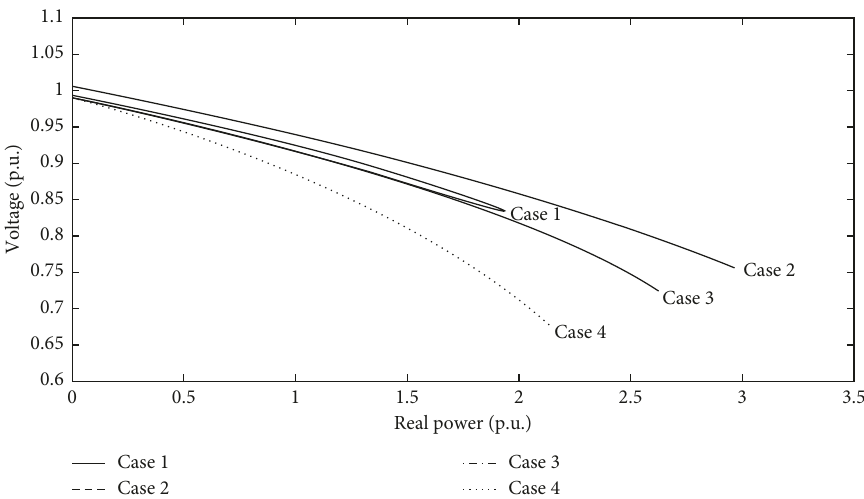
Figure 8: PV curves at the weakest bus of the IEEE 118-bus test